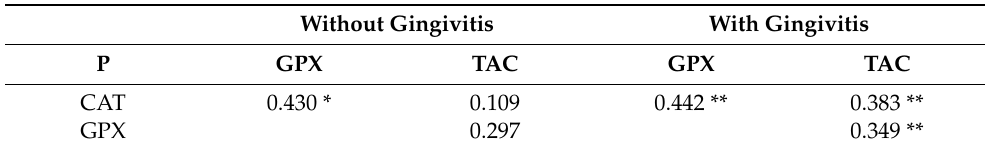
Table 5. Correlation of salivary total antioxidant capacity of saliva (TAC) and antioxidant enzymes— catalase (CAT) and glutathione peroxidase (GPX) in the group of subjects with and without gingivitis (Spearman’s rank correlation coefficient).